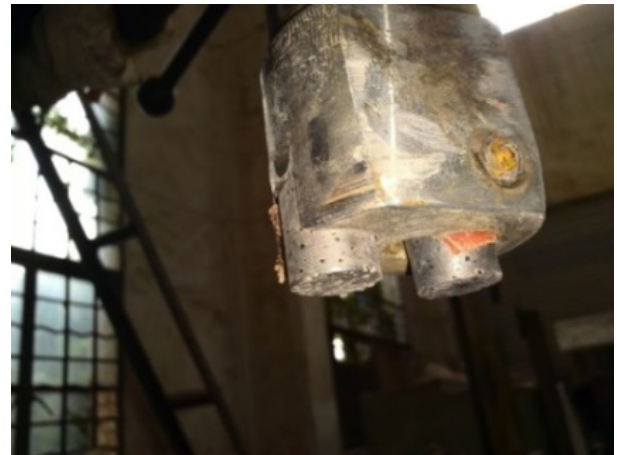
Figure 4. Impregnated micro bit.